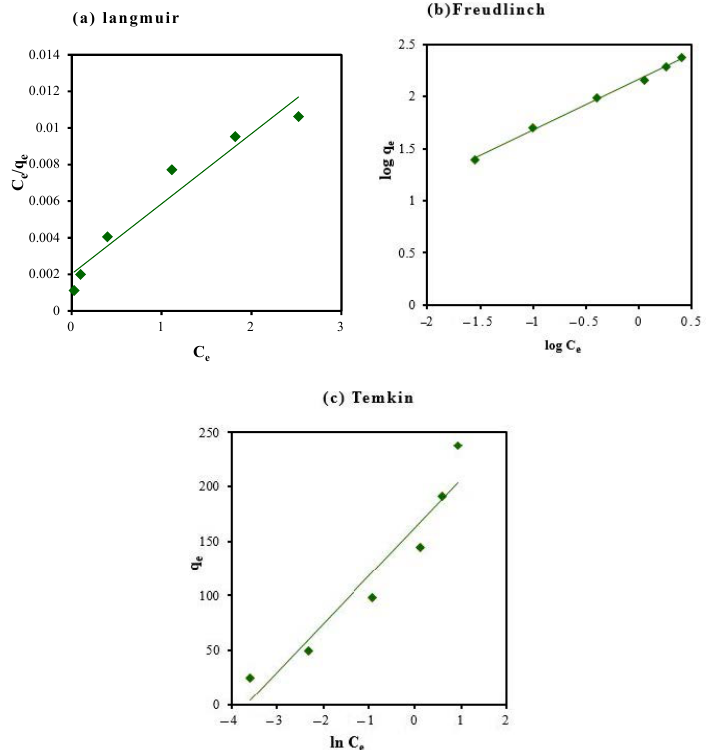
Figure 3. Isotherm adsorption models of dicamba. ( a ) Langmuir, ( b ) Freundlich, and ( c ) Temkin. Dosage: 20 mg; concentration of dicamba, 20 mg L − 1 ; temperature, 40 °C; equilibration time, 25 min and rpm, 150.